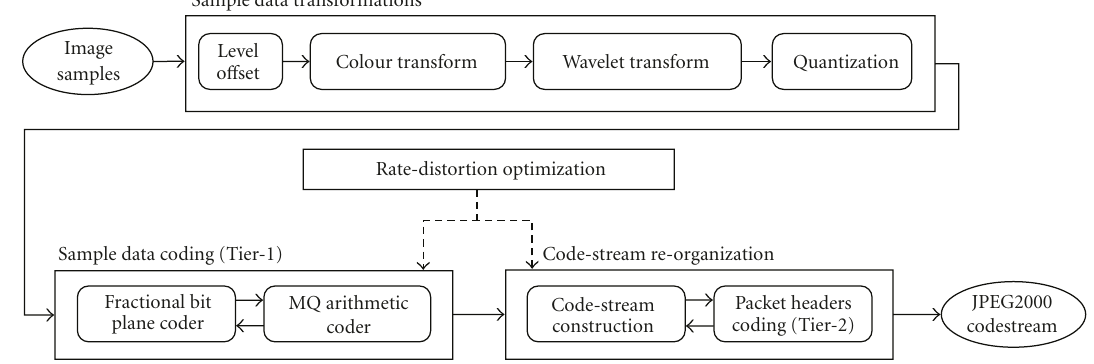
Figure 1: Detailed scheme of the main coding stages and operations carried out by JPEG2000 core coding